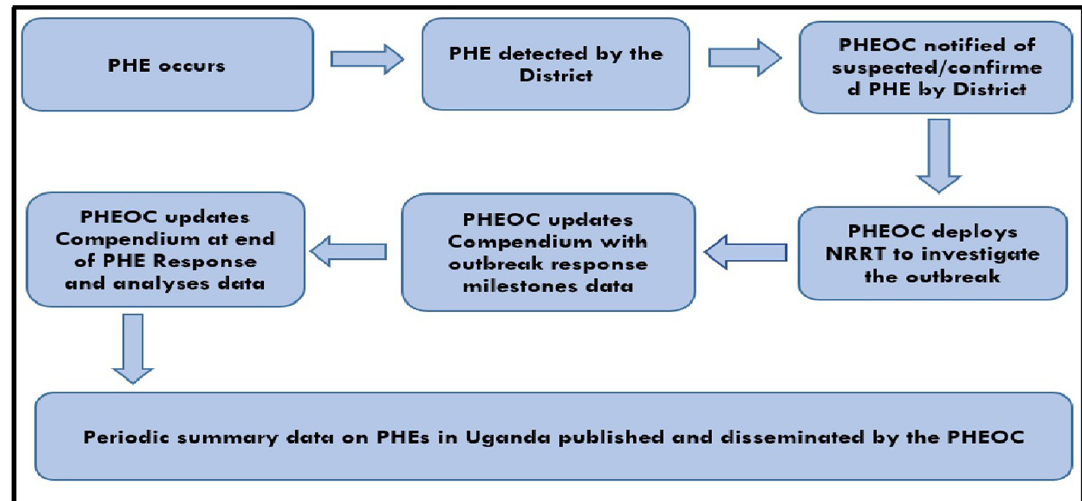
Fig 1. Process of prospective data collection and entry into the